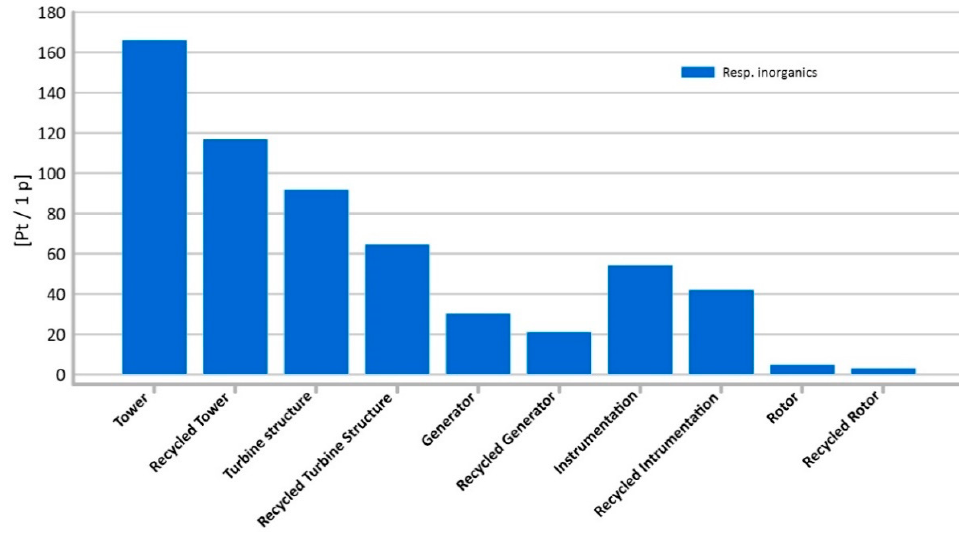
Figure 9. Results of grouping and weighting—respiratory